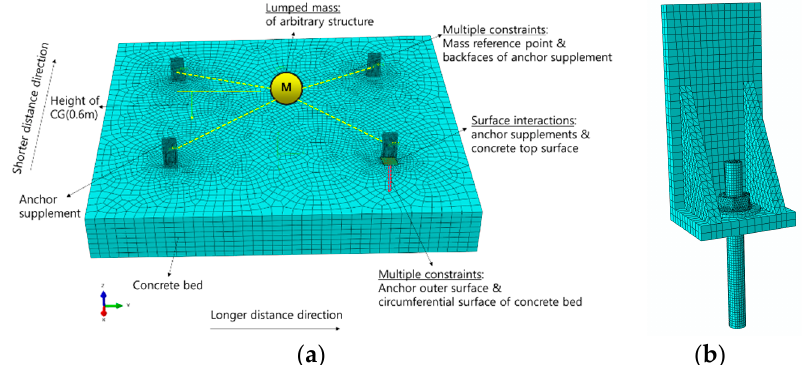
Figure 14. ( a ) Finite element model used for dynamic time history analysis under an earthquake load. ( b ) Model for the anchor and steel supplements.